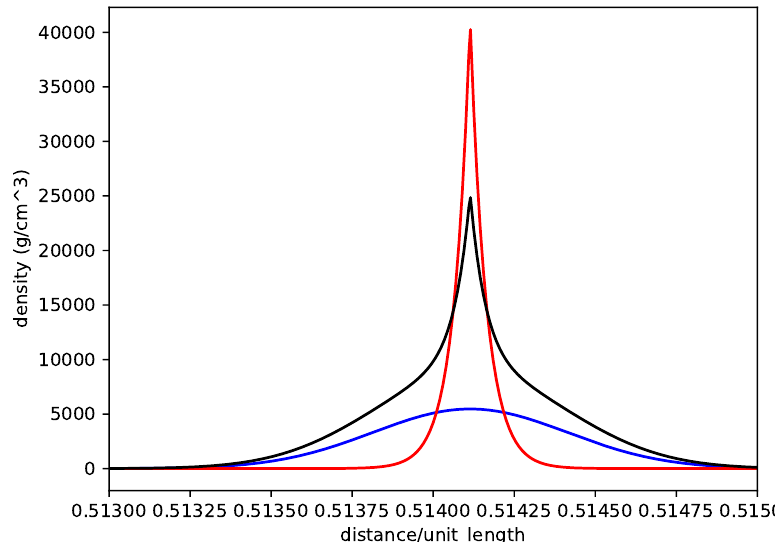
Figure 2. Profile of the electron density spikes used in the calculations multiplied by the proton mass, for comparison to equivalent matter density, Y e ρ equiv ( s ) = N e ( s ) m p . The horizontal axis represents a small window in the dimensionless parameter s (see text after Equation